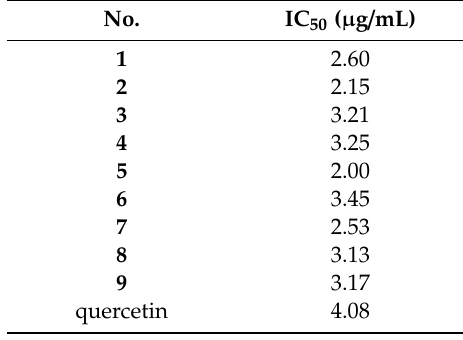
Table 3. E ff ect of compounds 1 – 9 on NO production stimulated by LPS in RAW264.7 cells.